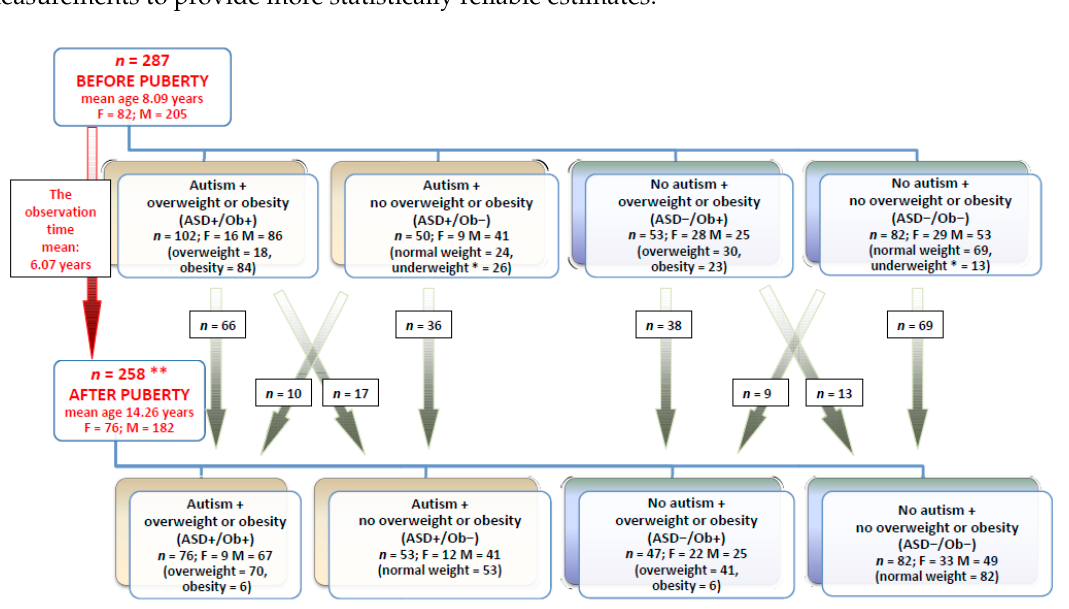
Figure 1. Allocation of pre- and post-pubertal children to groups. F—female, M—male. * Children with mild underweight (near-normal weight) who presented normal physical development and normalized weight after puberty (see below). ** A total of 29 children did not participate in the study after puberty. Children were diagnosed with underweight ( n = 39) according to the above mentioned BMI percentile charts (for age and gender) for the Polish population of children and adolescents [19]. BMI